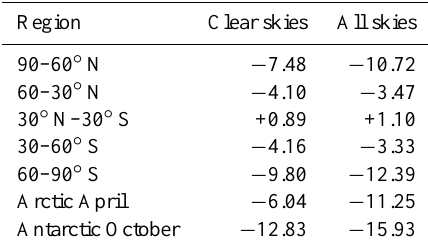
Table 2. Multi model mean changes (%) in clear-sky and all-sky annually averaged erythemal irradiance from 1975–1984 mean to 2090–2099 mean for different regions. Changes in monthly means are shown only for Arctic and Antarctic